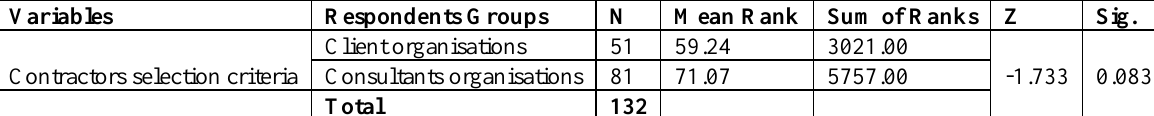
Table 6: Mann-Whitney U test for Contractors selection